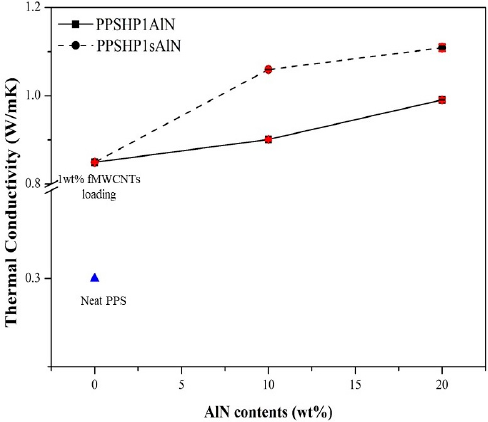
Figure 7. Thermal conductivity of the PPS/MWCNTs/AlN composites.